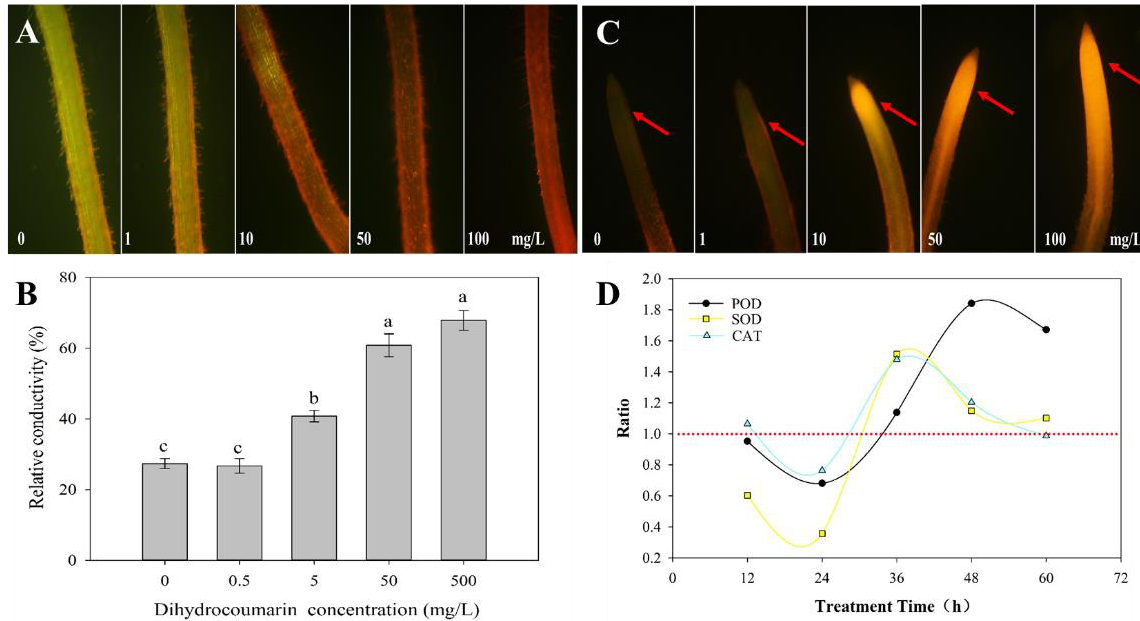
Figure 2. The effects of dihydrocoumarin on the growth of barnyardgrass. ( A ) The effects of dihydrocoumarin on the cell viability of barnyardgrass root. ( B ) The effects of dihydrocoumarin on the relative conductivity of barnyardgrass root. ( C ) The effects of dihydrocoumarin on ROS production in barnyardgrass roots. The arrows point to the luminous tissues of the root tip. ( D ) Contrast of controls and treatments on the antioxidant enzyme activities of barnyardgrass when treated with dihydrocoumarin at 50 mg/L. The ratio is the average enzyme activity of the treatment group divided by the simultaneous average enzyme activity of the control group.